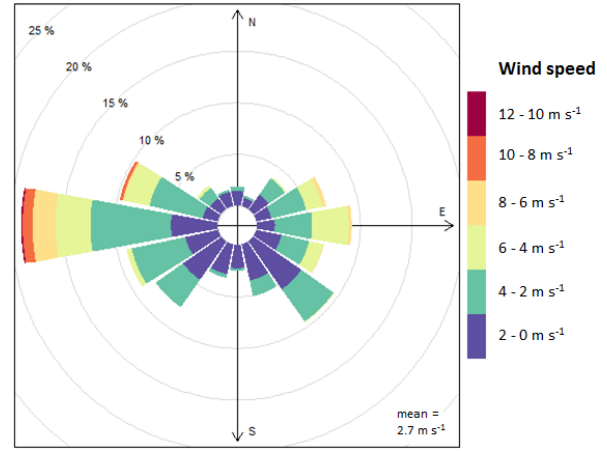
Figure 3. Wind rose of March 2015. Contribution expressed in per- cent corresponds to the frequency of counts by wind